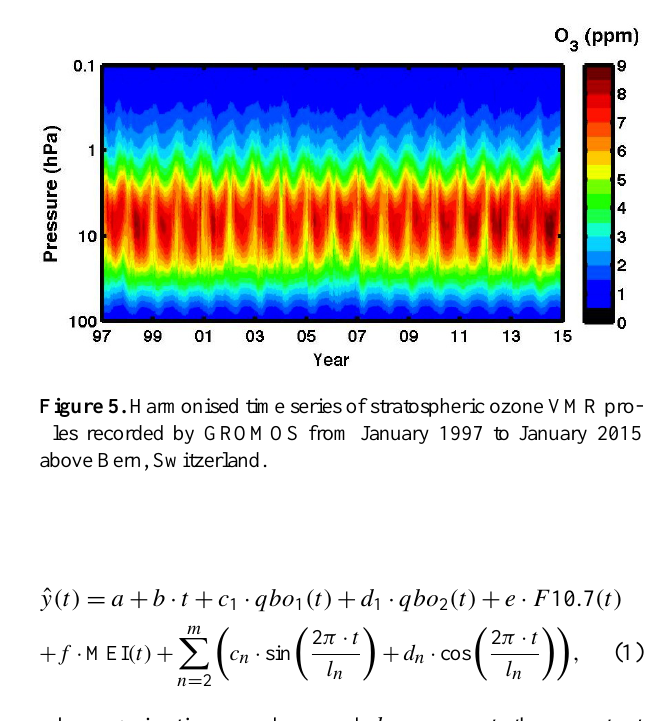
Figure 4. Harmonisation of ozone profiles retrieved from the FB (red line in the left panel) and FFT (blue line in the left panel) spec- trometers. The blue area (FFTS) and the red area (FB) are the stan- dard deviation of the measurements. The bias between FB and FFTS is less than 5% (middle panel) as derived from the overlap measure- ment (2009 to 2011) of ozone profiles at pressure levels from 30 to 0.3hPa (valid altitude range of GROMOS, green box). The grey area in the middle panel is the standard deviation of the differences.